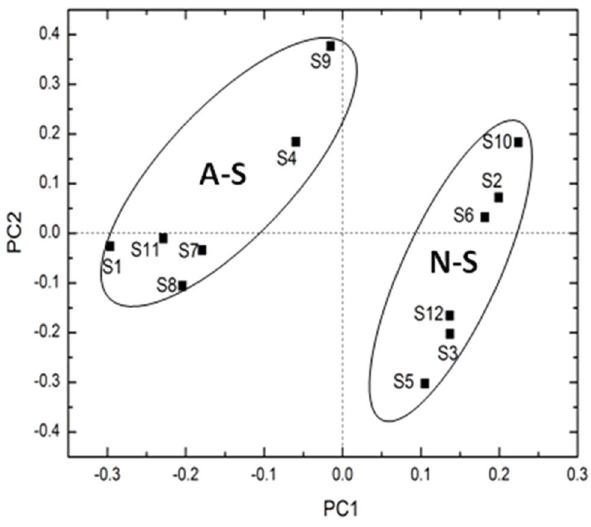
Figure 2. Principal component analysis (PCA) of the survival parameters ( d , p and t d ). d , p and t d are the same as shown in Table 2. A-S: acidic soils; N-S: neutral and slight alkaline soils. doi:10.1371/journal.pone.0081178.g002 PLOS ONE |